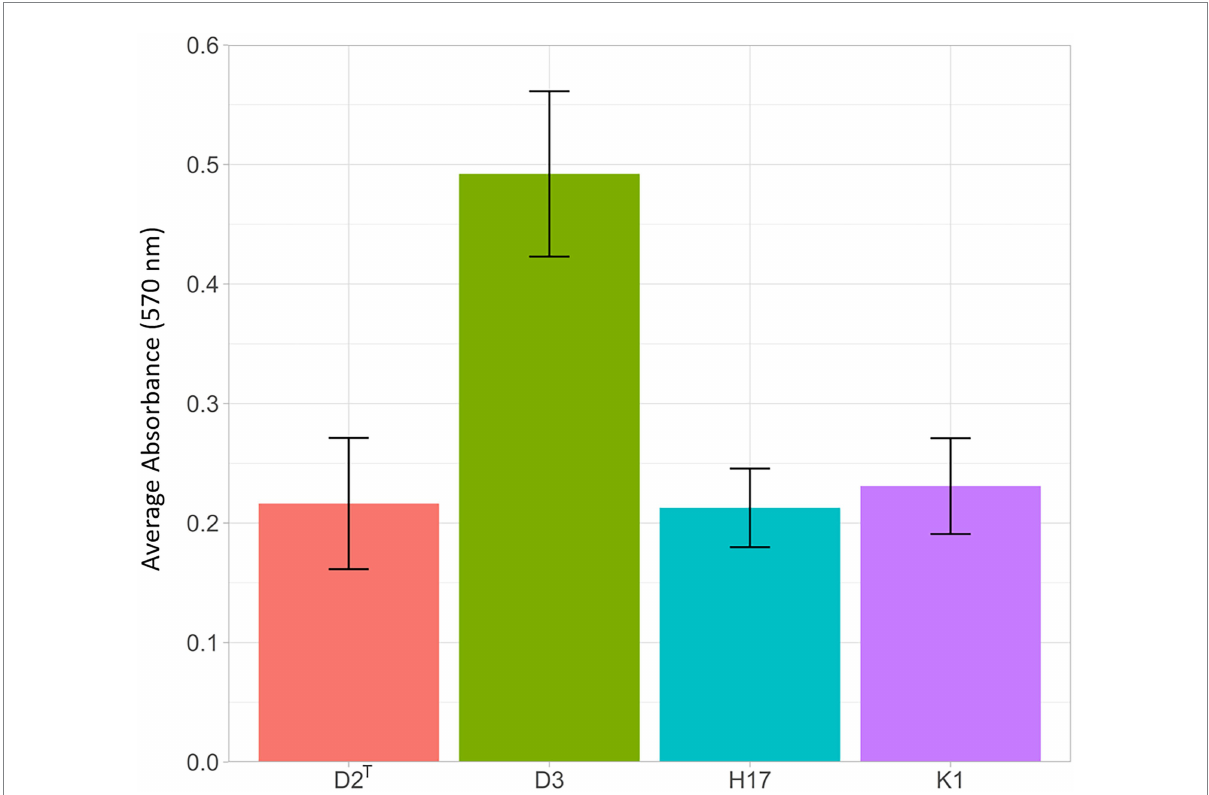
FIGURE 6 Results of crystal violet biofilm assay. Strains were incubated for 24 h at 37°C in 96-well plates and stained with 0.5% crystal violet for 30 min, after dissolving with ethanol (95%), staining intensity was measured at 570 nm in a 1:10 dilution in PBS. The bars show the average absorbance at 570 nm of three individual experiments with the according standard